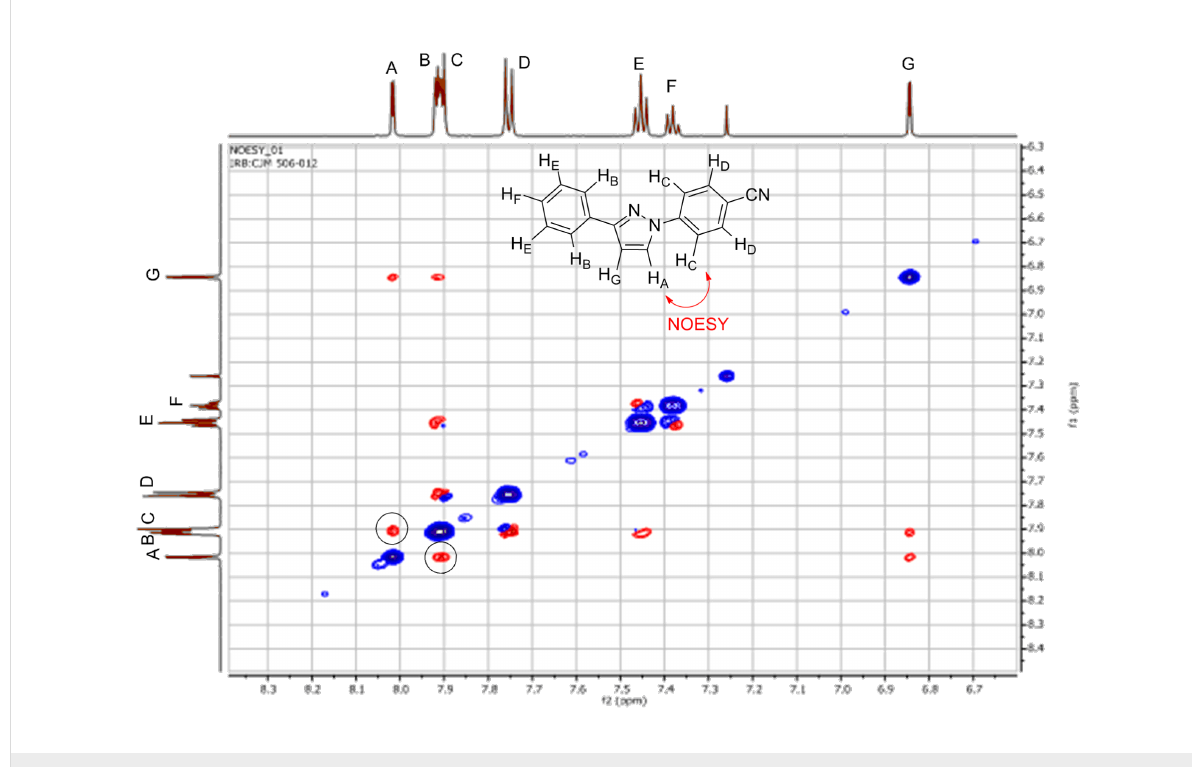
Figure 5: NOESY NMR spectrum for 33 with the characteristic NOESY signal encircled.